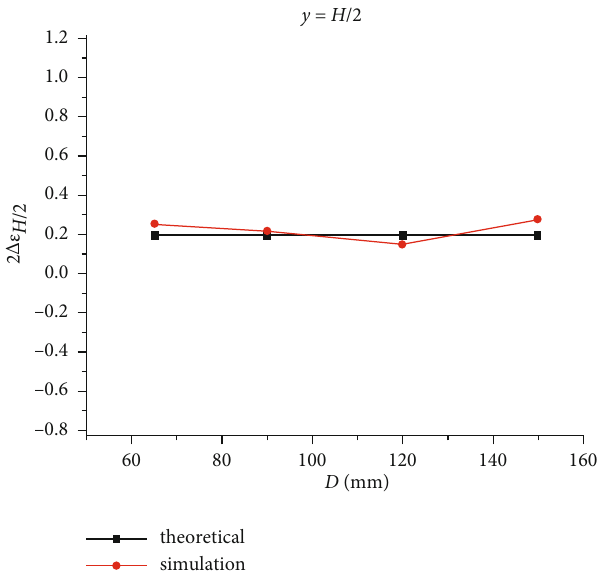
Figure 10: Elongational deformation of fl uid on both sides of pin at y = H /2